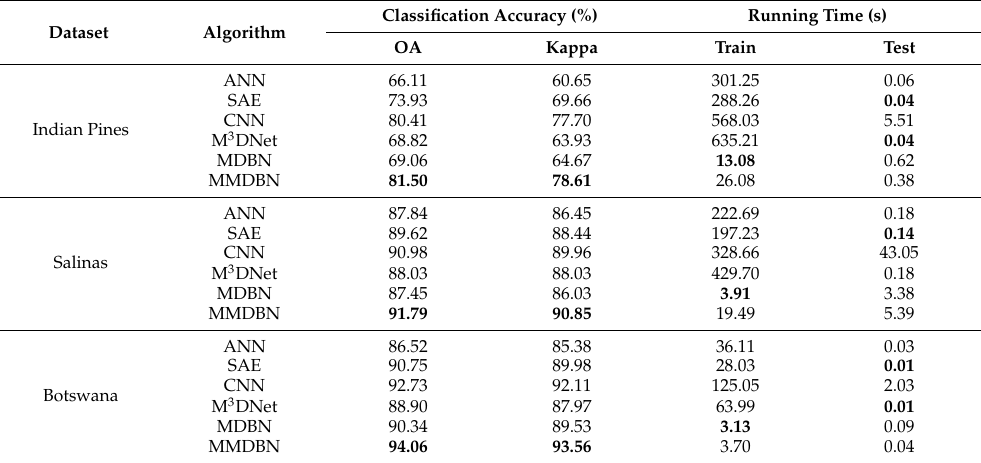
Table 8. Classification accuracy (%) and running time (seconds) of different deep learning models. Dataset